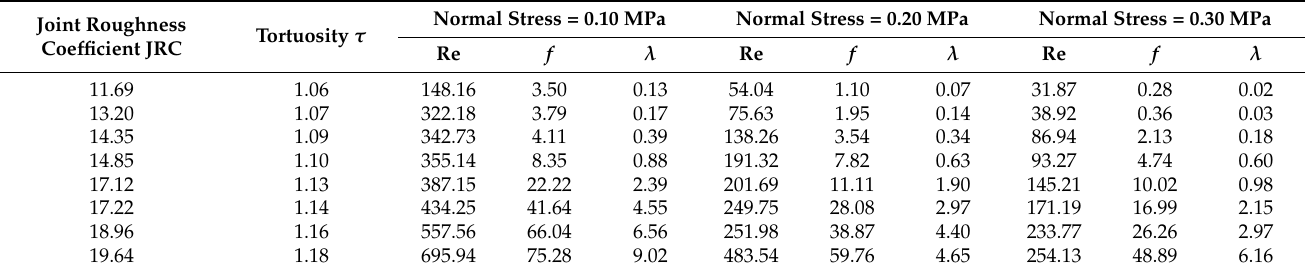
Table 6. Changes in the Reynolds number, friction resistance coefficient, and tortuous resistance coefficient in rough